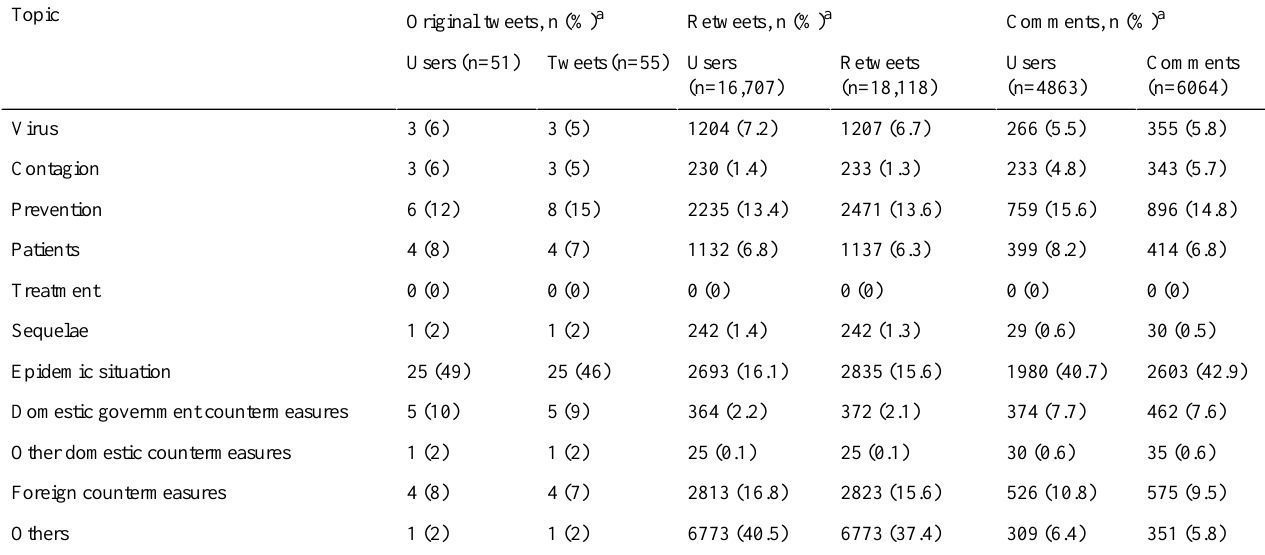
Table 2. Topic distribution of original rumor rebuttal tweets and their retweets and comments.